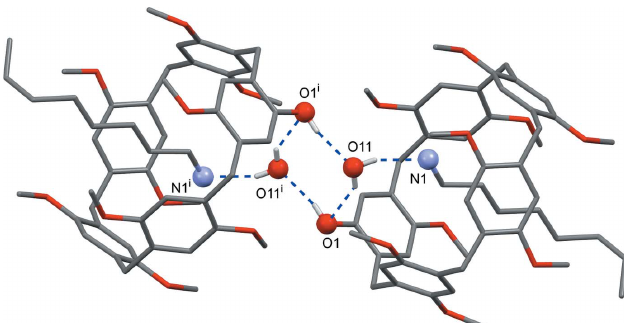
Figure 2 Hydrogen-bonding interactions between Pil-OH (cid:2) OctNH 2 systems showing the formation of a water-molecule-mediated supramolecular dimer. [Symmetry code: (i) (cid:3) x + 2, (cid:3) y + 1, (cid:3) z + 1.]